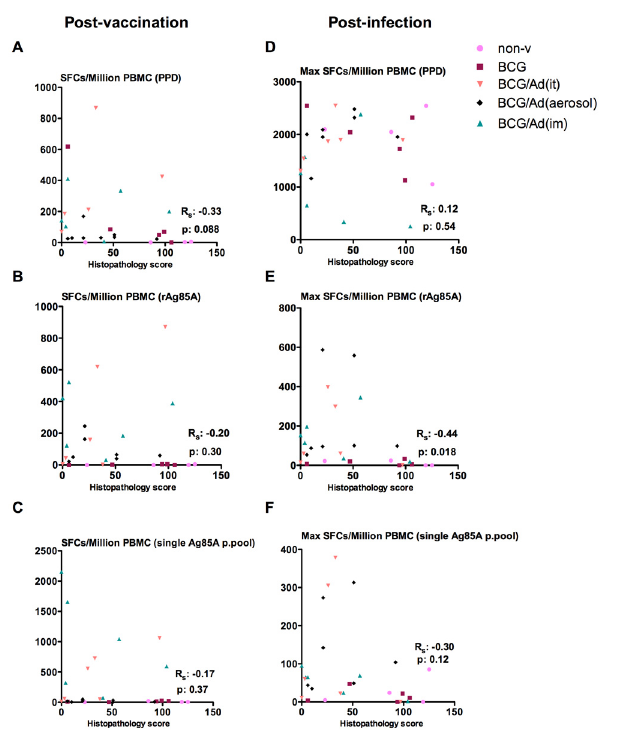
Fig 8. Correlation of vaccine-activated T cell responses with lung histopathology post-vaccination and post-infection. Maximal PPD-specific PBMC IFN- γ responses post-vaccination and maximal rAg85A- specific IFN- γ responses post-infection show significant inverse correlations with histopathology in the lung. Maximal antigen-specific PBMC responses for PPD ( A ), rAg85A ( B ) and single pool ( C ) post-vaccination are plotted per individual animal against histopathological scores. Maximal antigen-specific PBMC responses for PPD ( D ), rAg85A ( E ) and single pool ( F ) post-infection are plotted per individual animal against histopathological scores. Spearman ’ s rho (Rs) correlation factors and p-values are indicated.